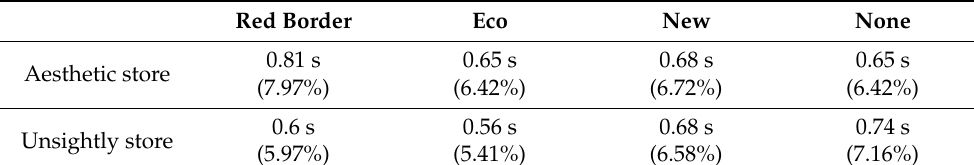
Table 2. Average time of fixation on a single product, depending on individual highlight or the lack thereof. This value is given in parentheses as a percentage of the total average viewing time for all products.